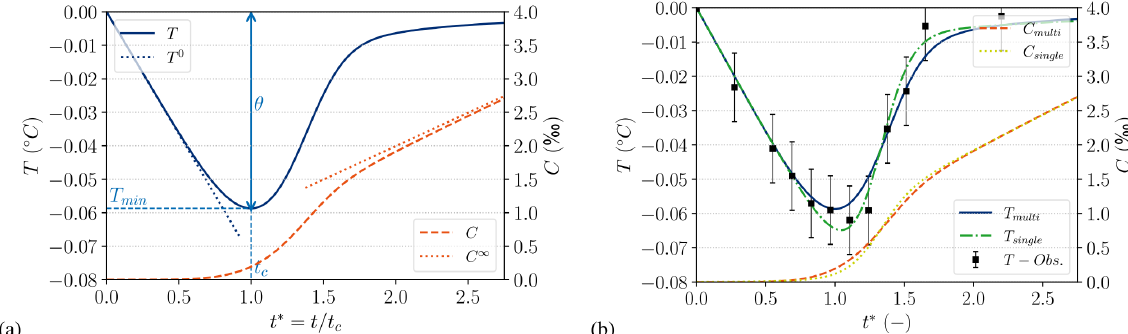
Figure 2. Typical evolution of water temperature and frazil volume fraction vs. time (a) and reproduction of Carstens (1966) case 1 experi- ments (b) with d t = 0 . 1s, φ = − 1400Wm − 3 , ε = 1 . 2 × 10 − 3 m 2 s − 3 , α T = 0 . 0876, n max = 8 × 10 6 m − 1 , a f = 10 − 4 s − 1 , τ s = 0m − 2 s − 1 , a d = 0, r = 3 . 8 × 10 − 4 m, R = 10, C 0 = 5 . 1 × 10 − 6 (SSC) and C 0 = 4 . 5 × 10 − 8 (MSC), r 0 = 0 . 2m, r min = 10 − 5 m, r max = 10 − 3 m, m = 100, and δ T = λ